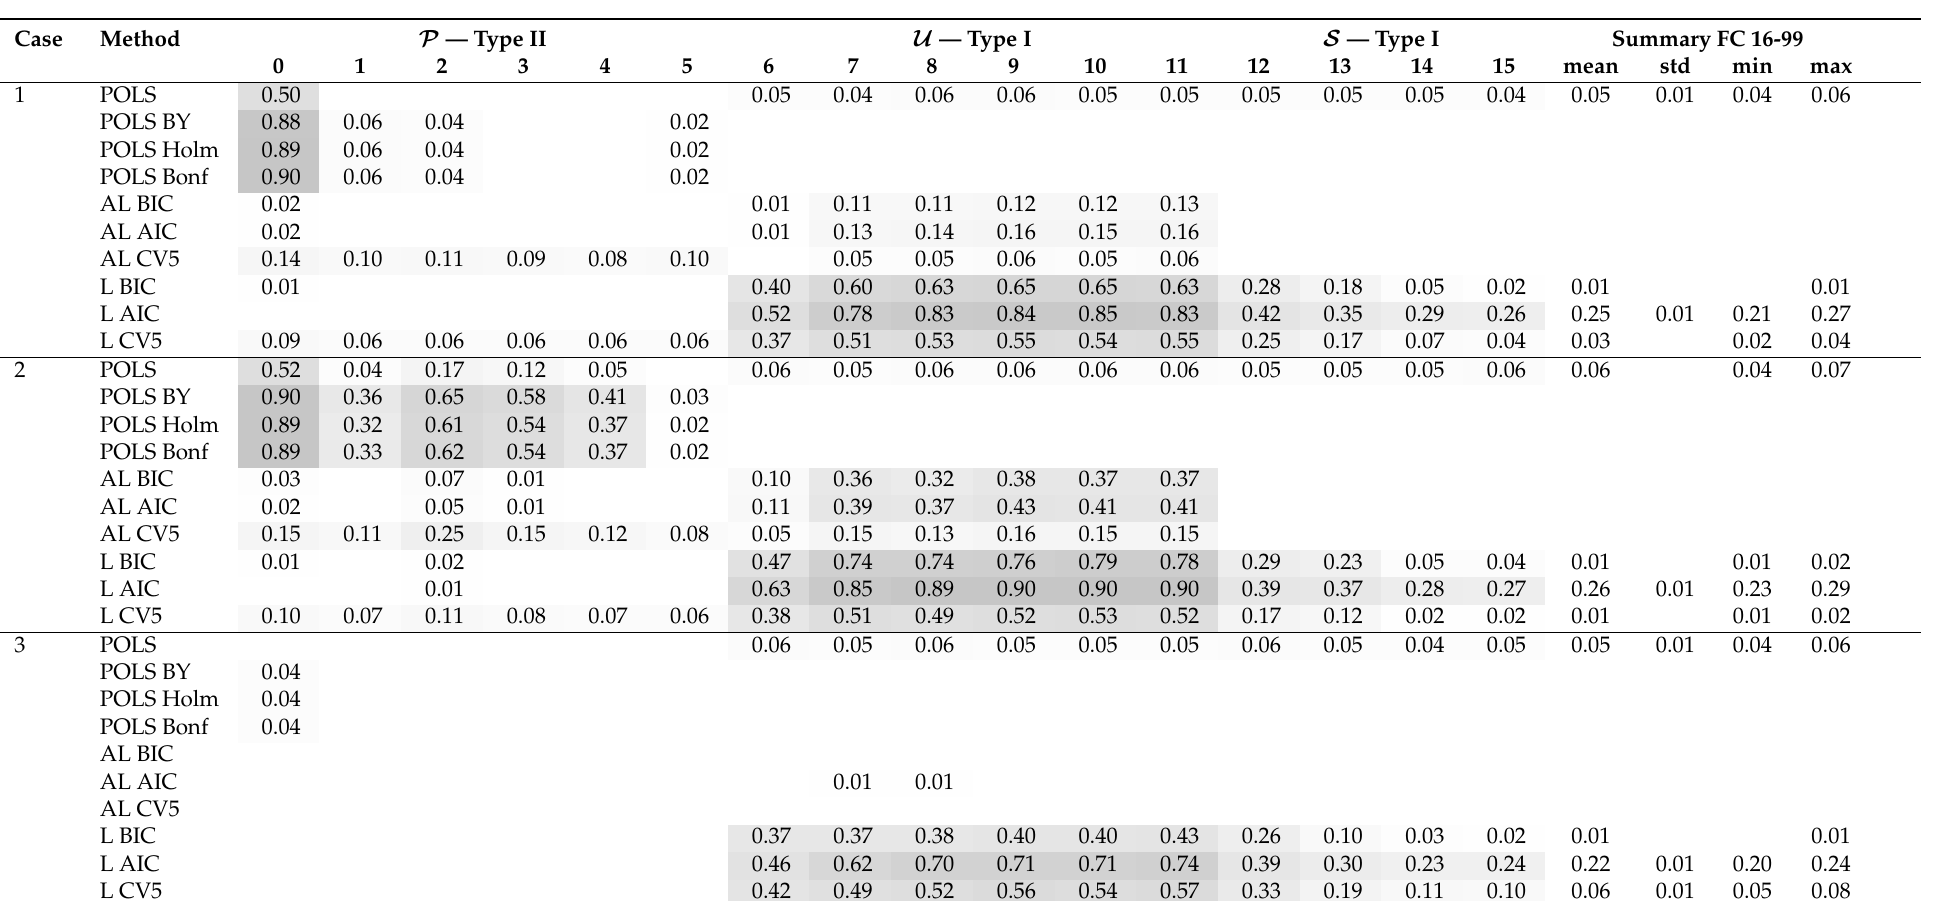
Table 1. Simulation Results: The table provides an overview of type II (for priced factor FC, FC 0–5) and type I error (for unpriced factor FC, 6-11, and spurious FC, 12–99) ratio behavior in percentage points for the specified simulation cases. All details of the cases can be found in Section 3.2. FC cases 12–15 are interesting insofar as they are spurious FC with high correlations to priced and unpriced FC. A white space represents a zero